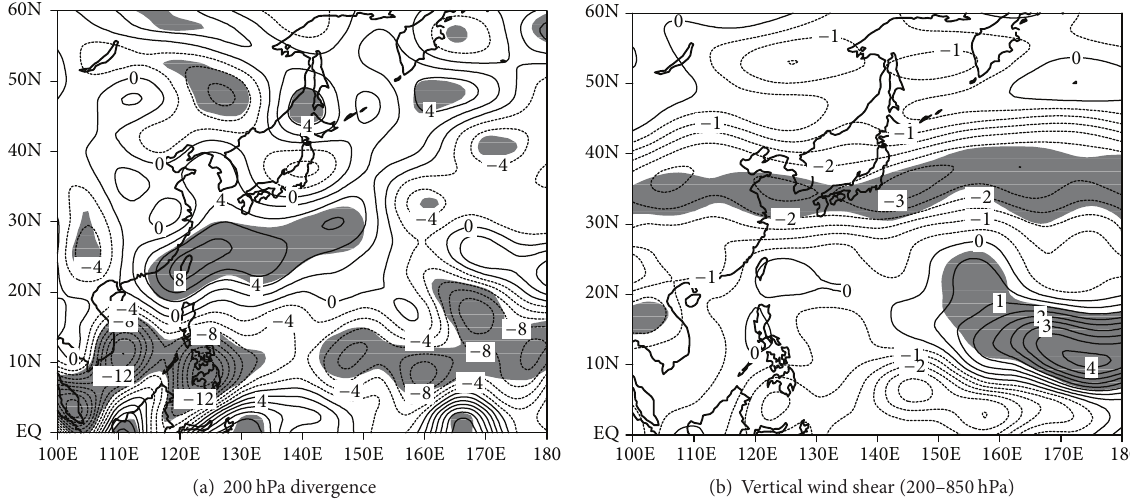
Figure 6: Same as in Figure 3, bur for (a) 200 hPa divergence and (b) vertical wind shear between 200 hPa and 850 hPa. Contour intervals are 2 ms −1 for 200hPa divergence and 0.5 ms −1 for vertical wind shear between 200hPa and 850 hPa. Shaded areas are significant at the 95% confidence